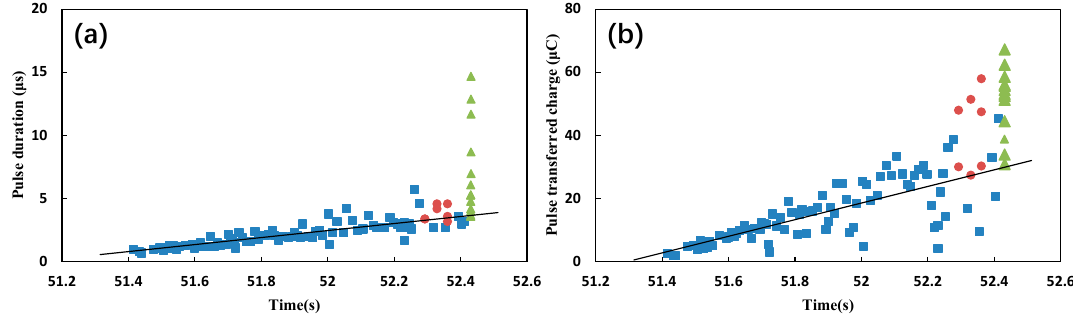
Figure 3. The pulse duration ( a ) and transferred charge ( b ) of triggered lightning 370 during its initial stage over time. Blue squares represent PCPs, red circles represent PCP clusters, green triangles represent IPCPs and the black line is the linear fitting line of the PCPs.